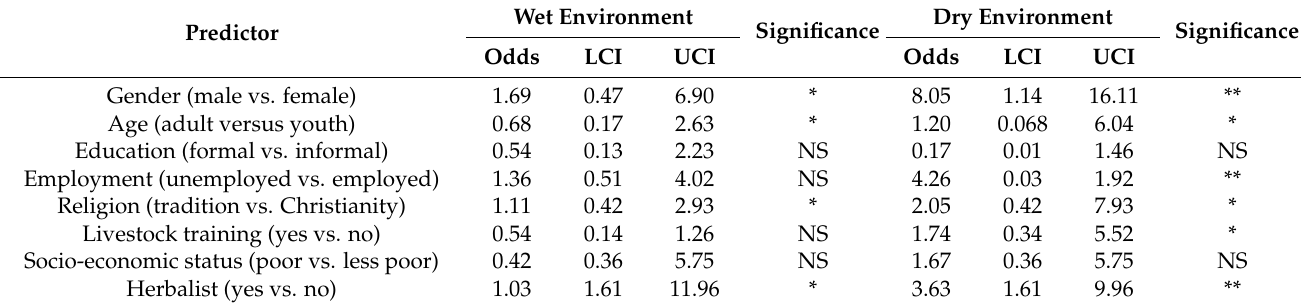
Table 3. Odds ratio estimates, lower (LCI) and upper confidence interval (UCI) of the factors influencing the use of IK to control gastrointestinal nematodes in the wet and dry environment. Wet Environment Dry Environment Significance Significance Predictor Odds LCI